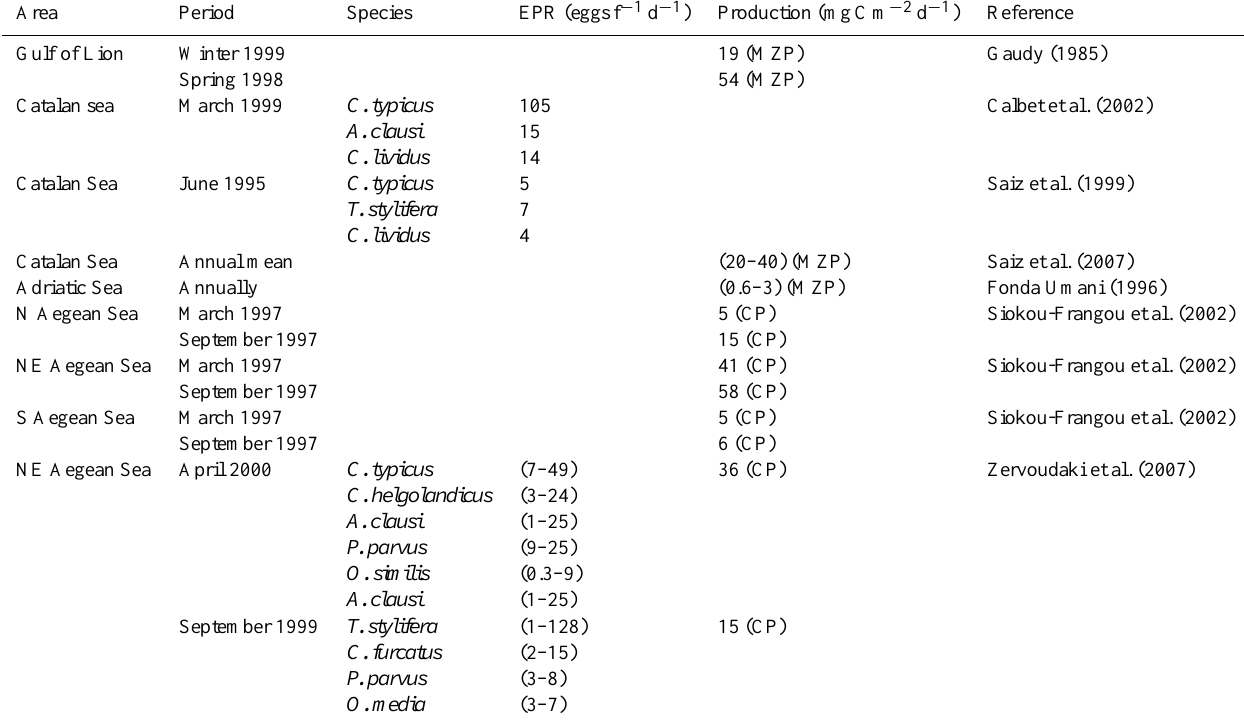
Table 7. Mean values (range) of egg production rates (EPR) and estimated copepod (CP) or mesozooplankton (MZP) production in areas of the Mediterranean